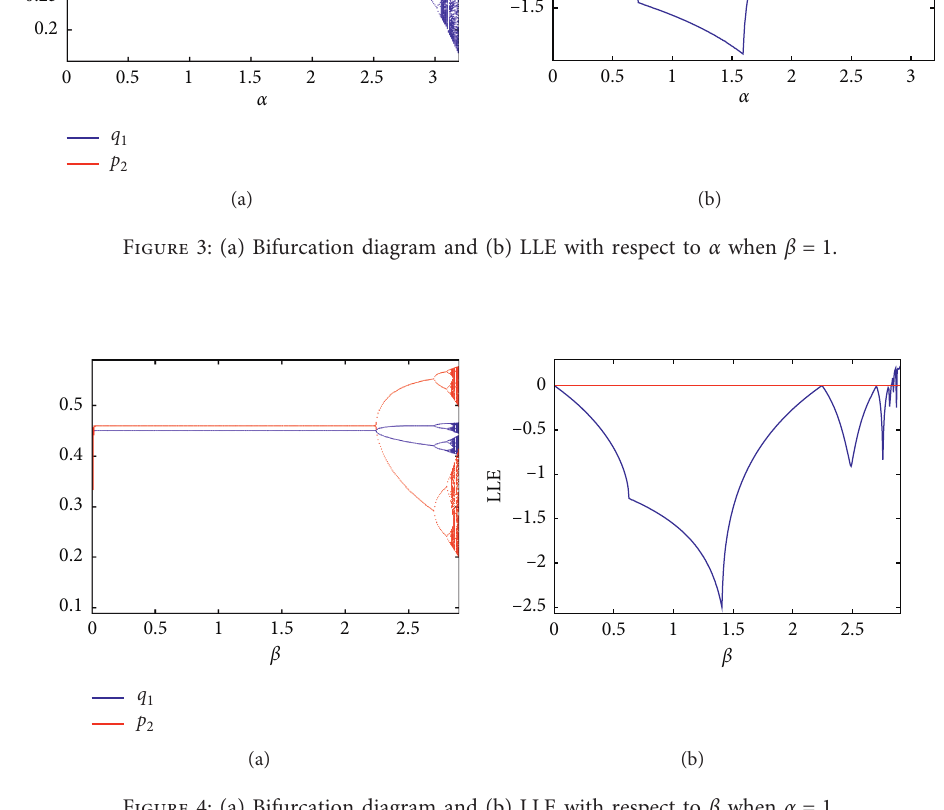
Figure 4: (a) Bifurcation diagram and (b) LLE with respect to β when α � 1.